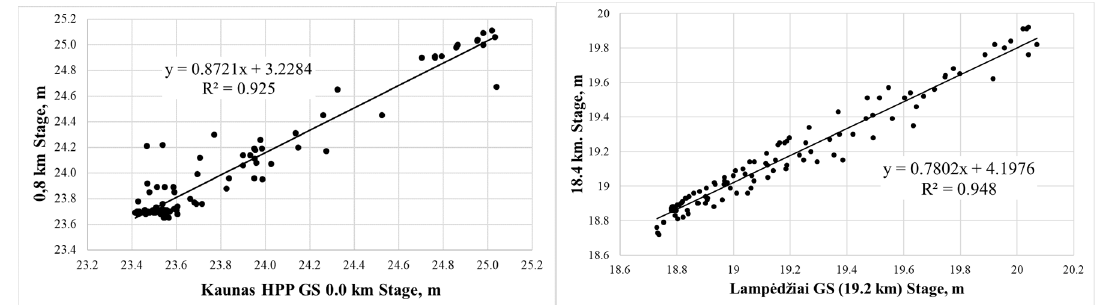
Figure 5. Correlation between river stage data from temporary stage measurement sites and permanent gauging stations. Left: Kaunas HPP gauging station and stage measurement site 0.8 km downstream from Kaunas HPP. Right: Lamp ė džiai gauging station 19.2 km and temporary measurement site 18.4 km downstream from Kaunas HPP.